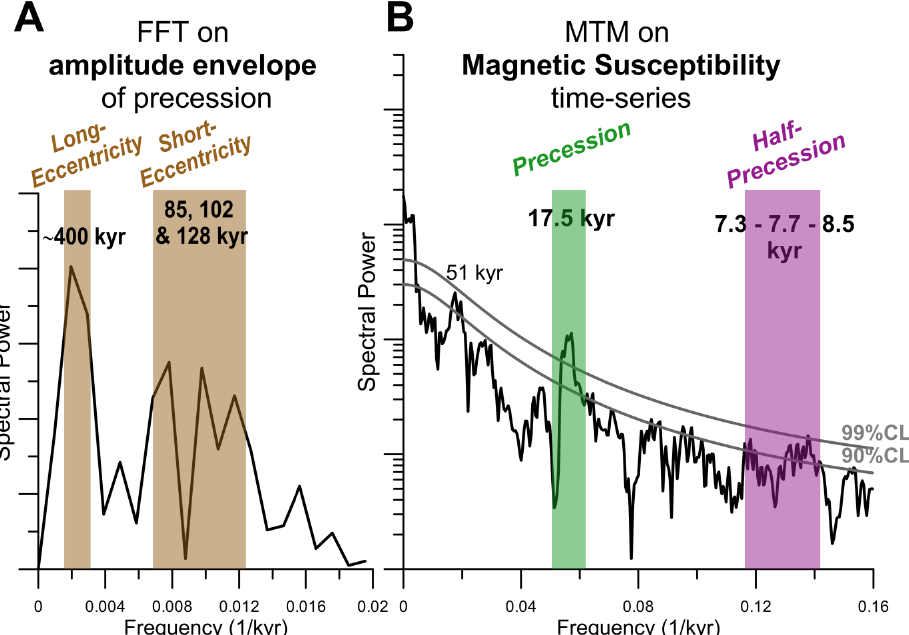
Fig. 5. Spectral analyses on the MS series of the “La Couvinoise” section as a whole. (A) : fast Fourier Transform (FFT) periodogram of the amplitude envelope of the precessional signal. A linear “spectral power” axis is chosen to give an immediate sense of how much of the variance comes from each cycle. (B) : multitaper method (MTM) power spectrum of the “La Couvinoise” MS data as a time-series. A logarithmic “spectral power” axis is chosen to make the statistical significance of peaks evident, particularly for small high-frequency peaks. CL=Confidence Limit.